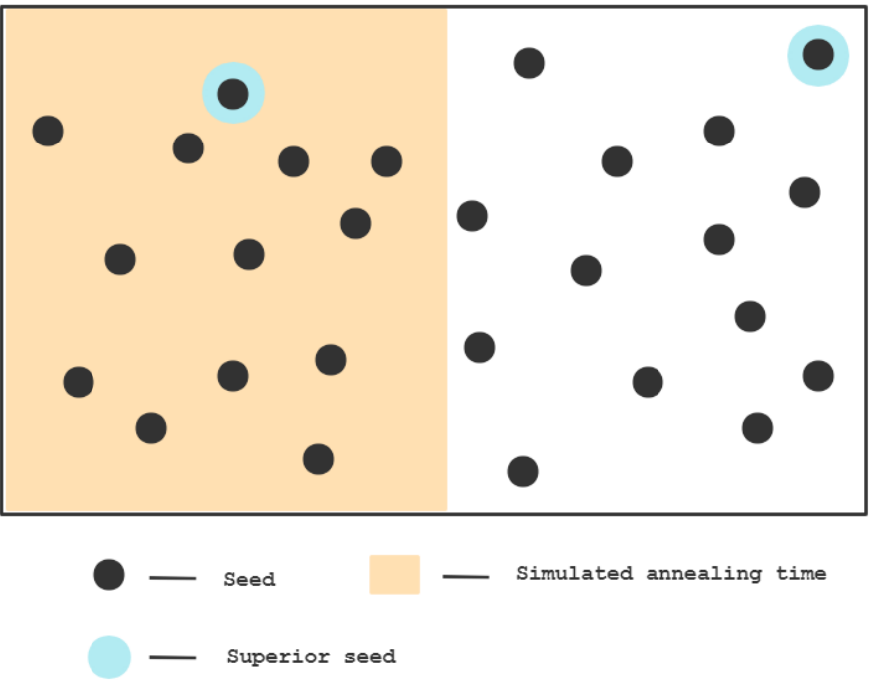
Figure 1. Simulated Annealing Power Limitations in Fuzzing.